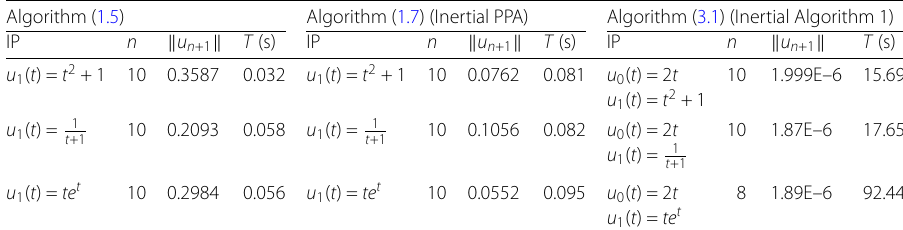
Table 1 Numerical results for Example 1 Algorithm (1.5)